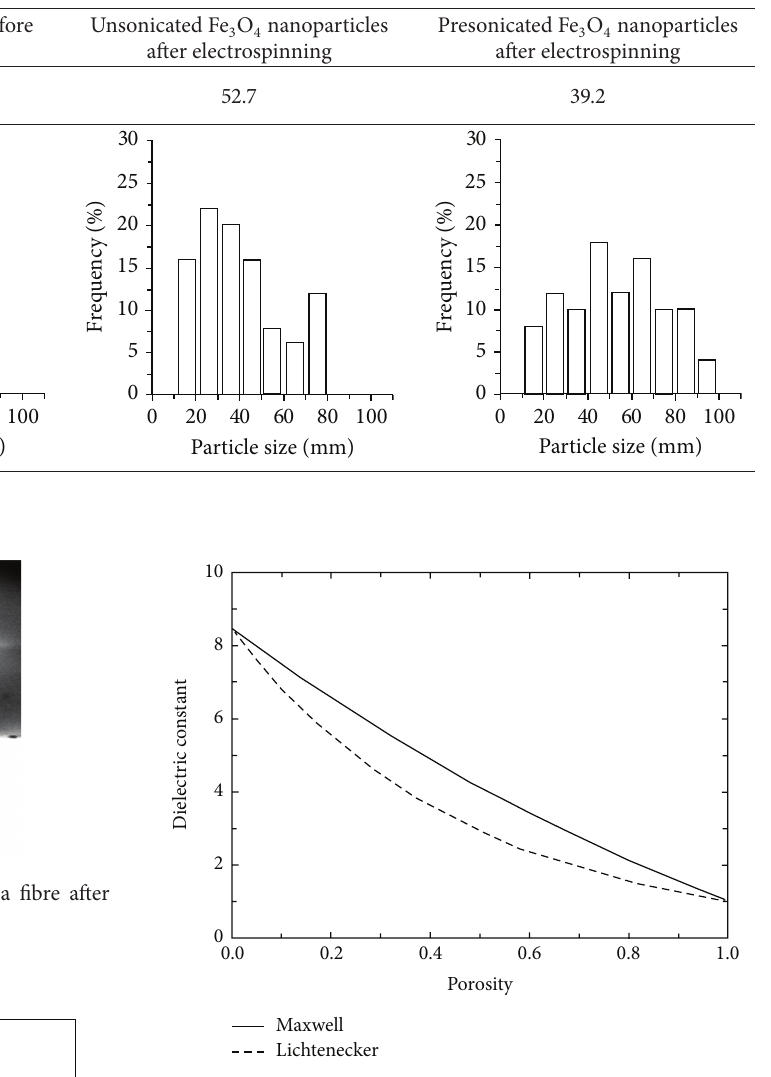
Figure 5: Calculated values of dielectric constant for electrospun PVdF/Fe 3 O 4 fibre webs as a function of web porosity based on the Maxwell and Lichtenecker mixing